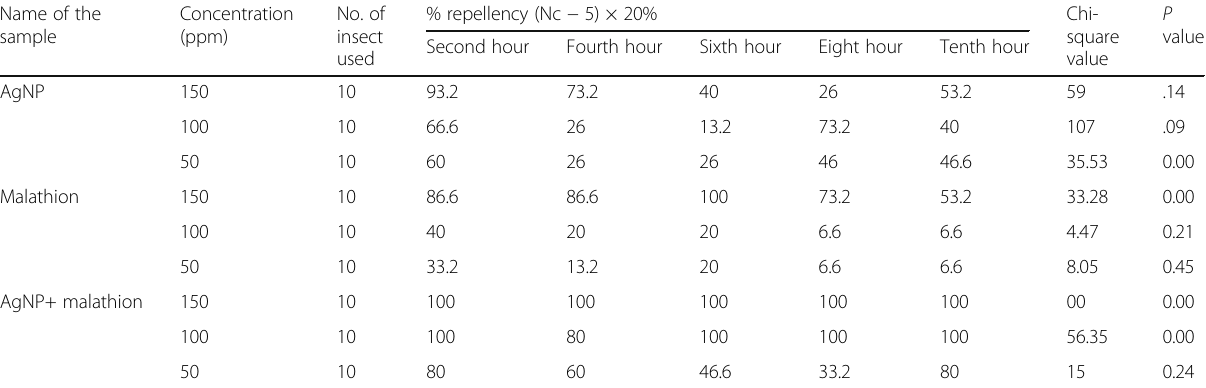
Table 5 Repellent activity of Tribolium castaneum against silver nanoparticles, malathion, and its combination Name of the sample